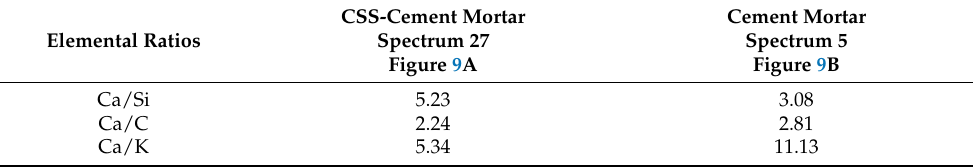
Table 4. Element composition from EDS